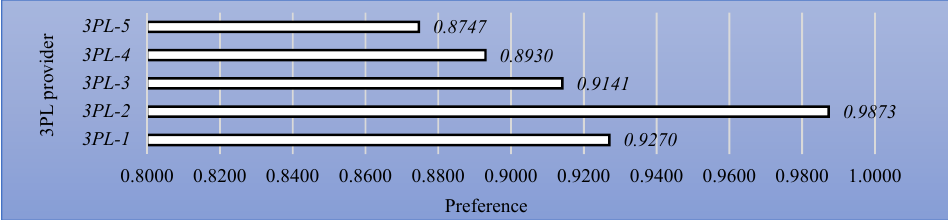
Figure 3. Final ranking of 3PL providers obtained by the hybrid–ARAS method (Source: Authors).